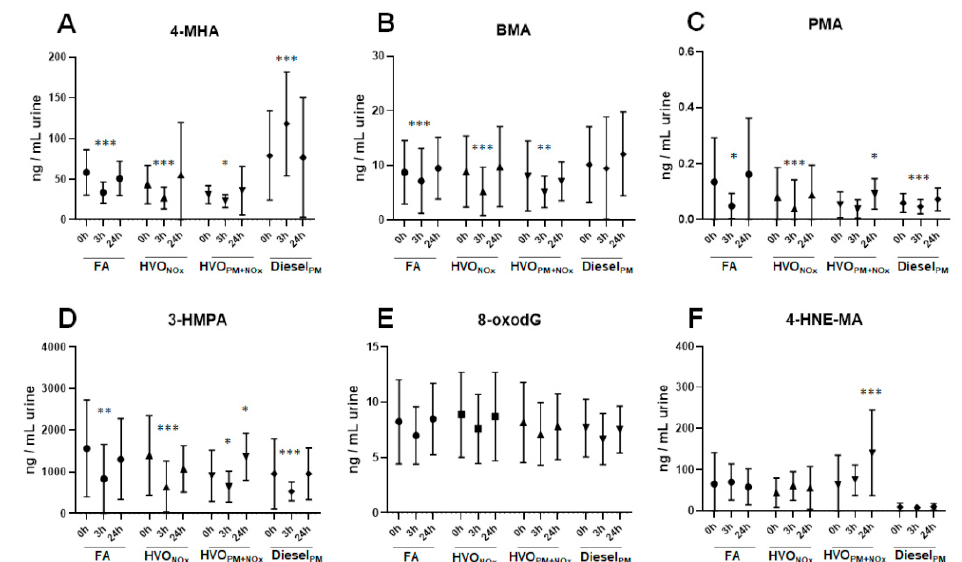
Figure 2. Urinary VOC metabolites, as well as 8oxodG and 4-HNE-MA, after different exposure scenarios. Average and standard deviation of the urinary biomarkers 4-MHA ( A ), BMA ( B ), PMA ( C ), 3-HPMA ( D ), 8-oxodG ( E ), and 4-HNE-MA ( F ) from 18 volunteers after exposure to: filtered air (FA), HVO exhaust from a modern non-road vehicle with exhaust aftertreatment (HVO NOx ) and without exhaust aftertreatment (HVO PM+NOx ), as well as petroleum diesel exhaust (Diesel PM ). Statistical analysis was performed using Wilcoxon signed rank test (* p < 0.05, ** p < 0.01, *** p < 0.001, different from t = 0 h). No significant difference was observed between FA and the particle control exposure (Salt PM ). All data are presented in Table S3. Only 4-MHA was increased after exposure (t = 3 h) to Diesel PM exhaust compared to before exposure (t = 0 h). Most other biomarkers decreased after 3 h of